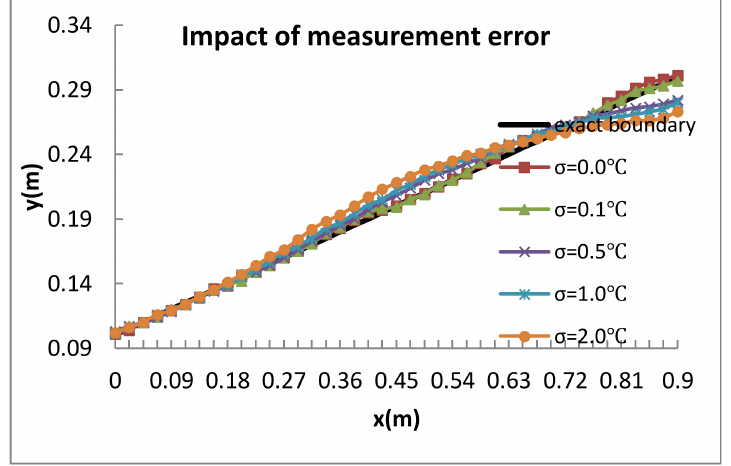
Figure 8. Identification results of di ff erent measurement errors for inversion results of case 1.